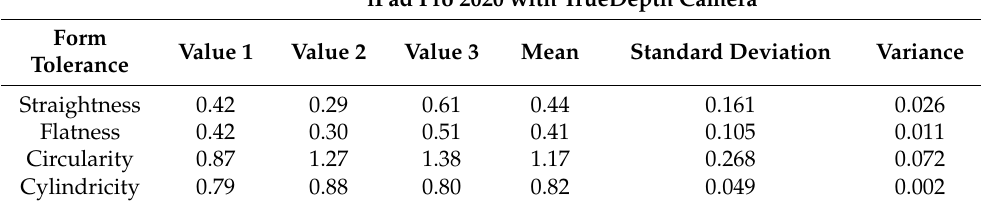
Table A4. Determined form tolerance values of different Lego bricks scanned by the iPad Pro (2020) using